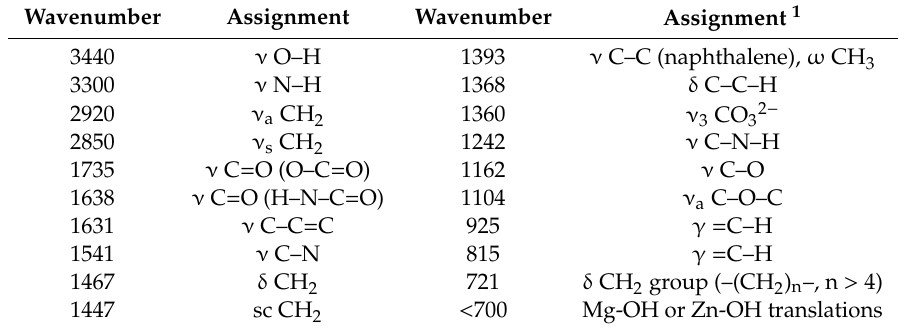
Table 3. IR wavenumbers (in cm −1 ) indicated in the spectra of PEBA membrane and PEBA composites and tentative assignments.